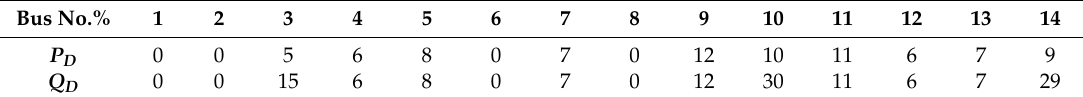
Table 6. Percentage of nonconforming system demand change in each bus for the IEEE 14-bus system. Bus No.%